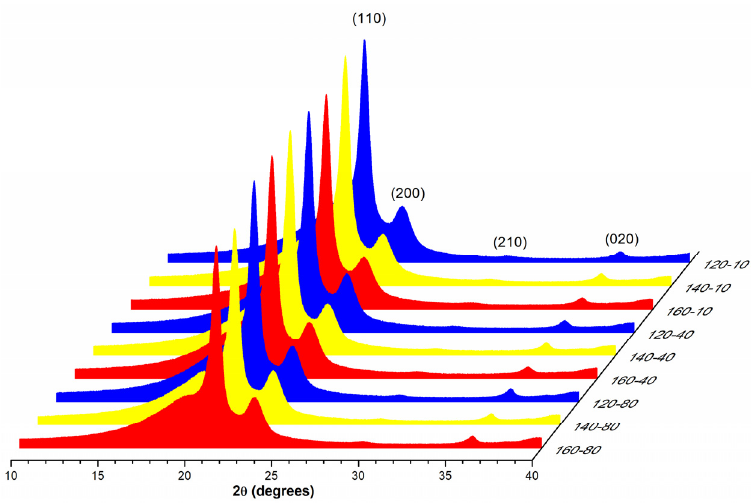
Figure 3. XRD diffractograms of LDPE injection- molded specimens.